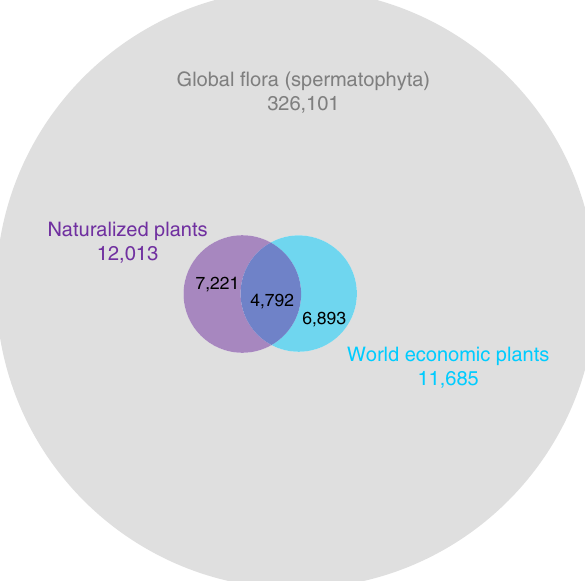
Fig. 1 The numbers of naturalized and economic plants in the extant global fl ora. The size-proportional Venn diagram shows the overlap in the number of taxa between the economic plants of the WEP dataset and the naturalized plants of the GloNAF database. For reference, the gray circle indicates the number of taxa with accepted names in the extant global seed plant fl ora according to The Plant List